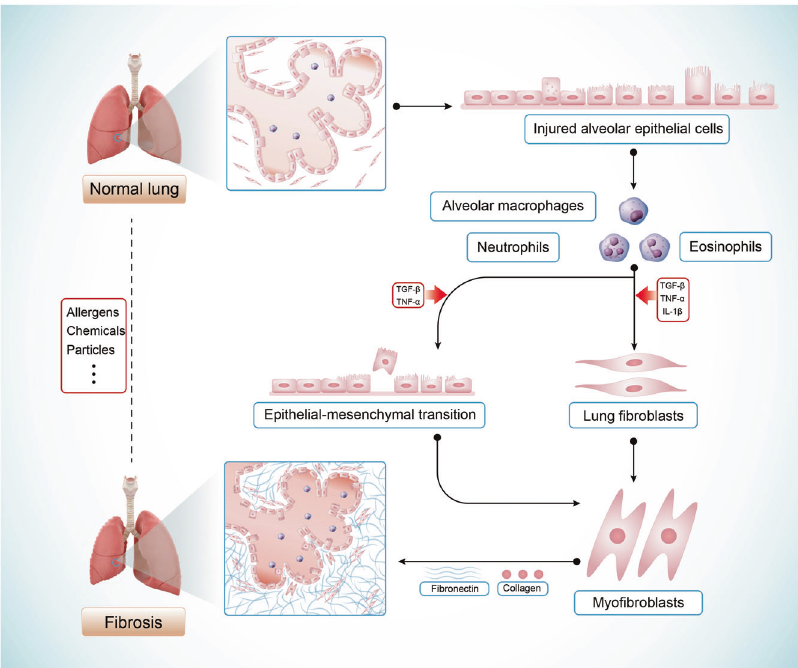
Fig. 3 The interactions among cells involved in lung fi brosis. Injured alveolar epithelial cells activate macrophages, neutrophils, and eosinophils, resulting in the secretion of cytokines, such as TGF- β , IL-1 β , and TNF- α . These cytokines mediate the differentiation of fi broblasts into myo fi broblasts and the epithelial-mesenchymal transition, which result in the ECM deposition at the injury